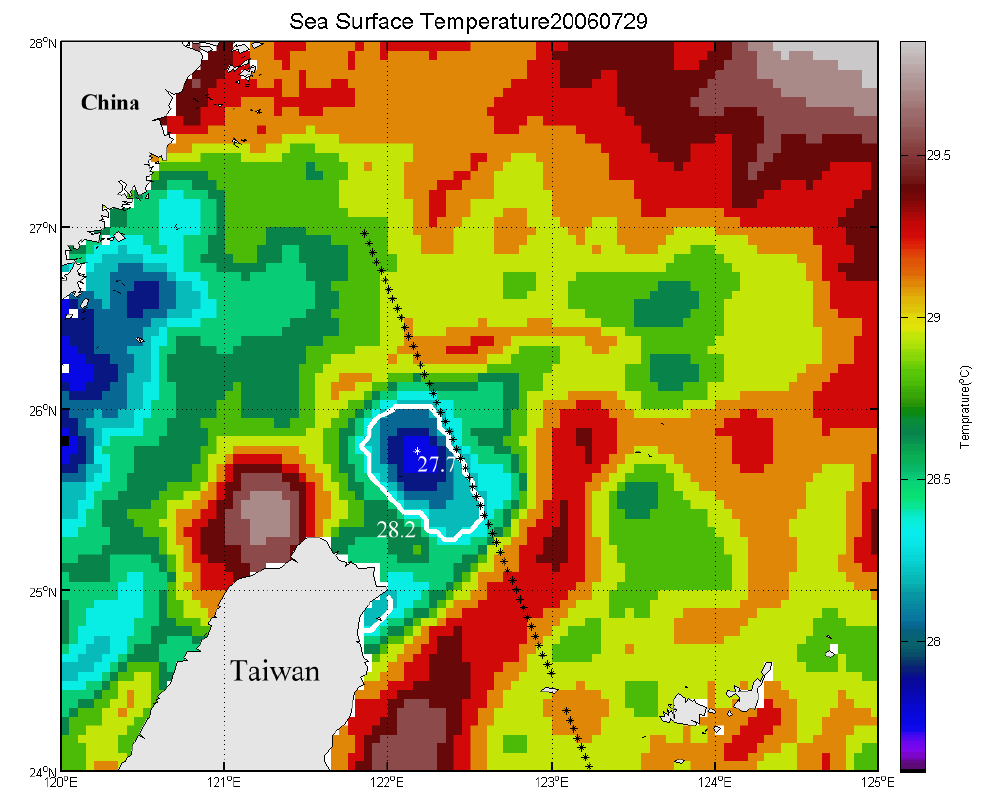
Figure 3. SST image of July 29, 2006. The lower SST i.e., the cold patch off northeast Taiwan is detected within the area of 27.7 ° C contour (white). The black dotted line is the ground track of T/P and